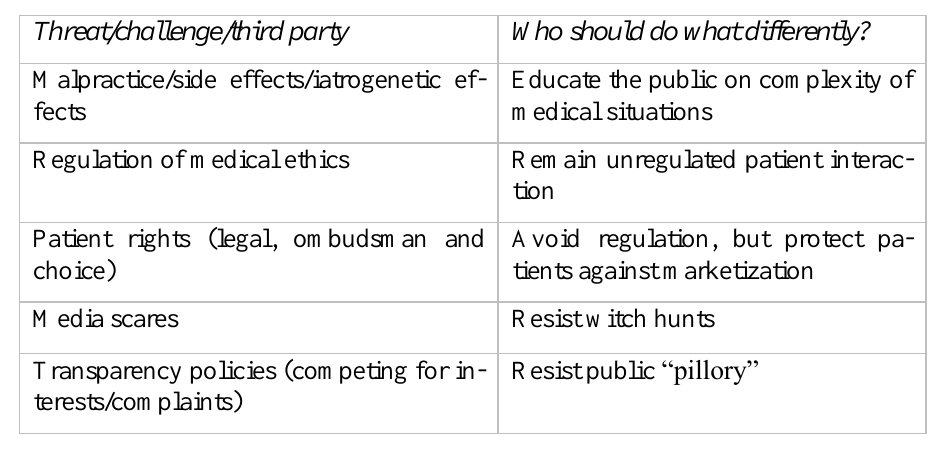
Danish doctors’ perceived threats to authority and proposed